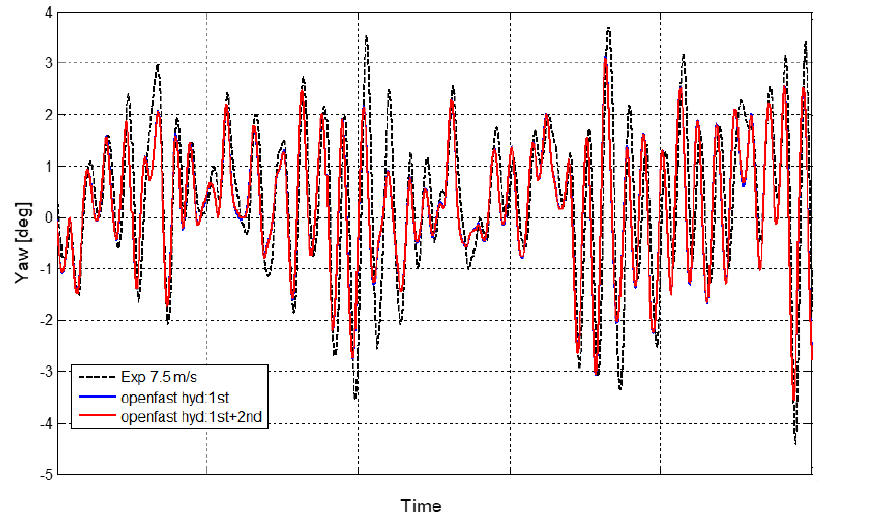
Figure 13. Yaw response of SATH 10MW under turbulent wind with average of 7.5ms − 1 and irregular waves with H s = 2 . 0m and T p = 8 . 5s.